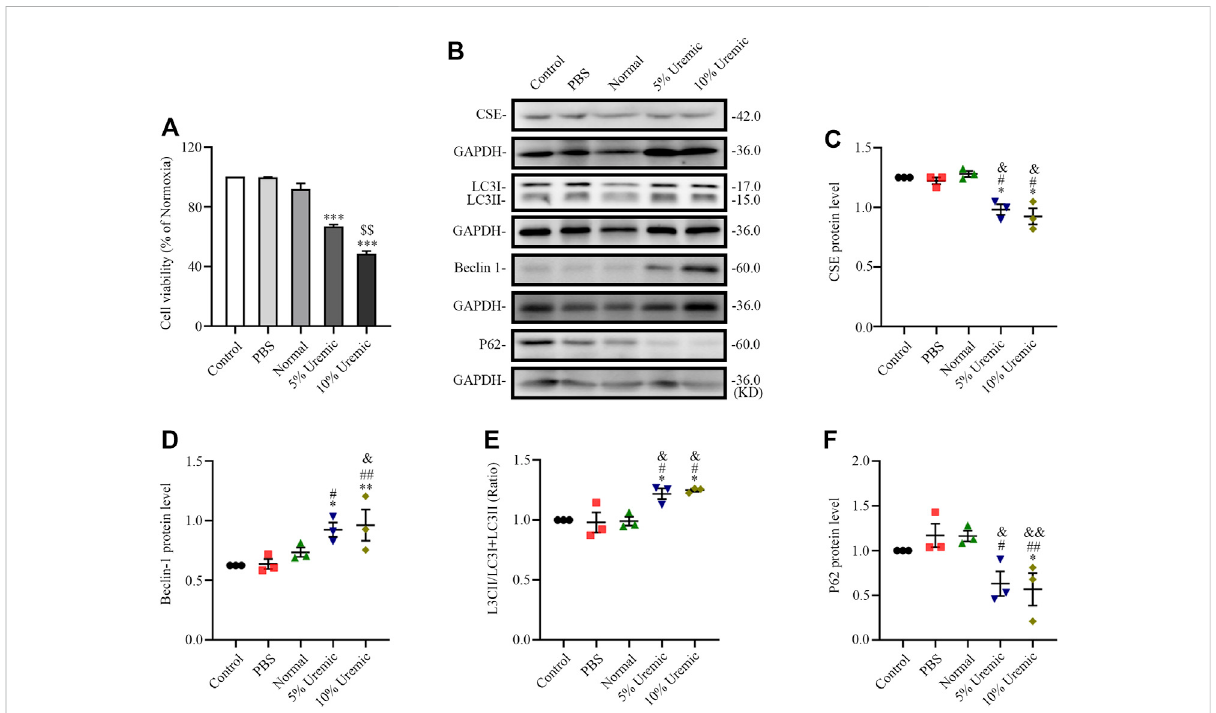
FIGURE 5 Effectsofserumuremiaontheexpressionsofcystathioninegamma-lyase(CSE)proteinandautophagy-associatedprotein. (A) Cellviabilitywas measured using the CCK-8 assay, with n = 3 per group. (B) Representative Western blot images of CSE, LC3, becline-1, and P62 in the fi ve groups of H9C2cardiomyocytes (C – F) Quanti fi cationoftheCSEproteinlevels,LC3II/LC3(I+II)ratio,becline-1proteinlevels,andp62proteinlevelsinthe fi ve groups of H9C2 cardiomyocytes. n = 3 per group. Data are represented as Mean ± SEM. * p < 0.05, ** p < 0.01, *** p < 0.001 vs. control group; # p < 0.05, ## p < 0.01 vs. PBS group; & p < 0.05, && p < 0.01 vs normal serum group; $$ p < 0.01 vs. 5% uremic serum